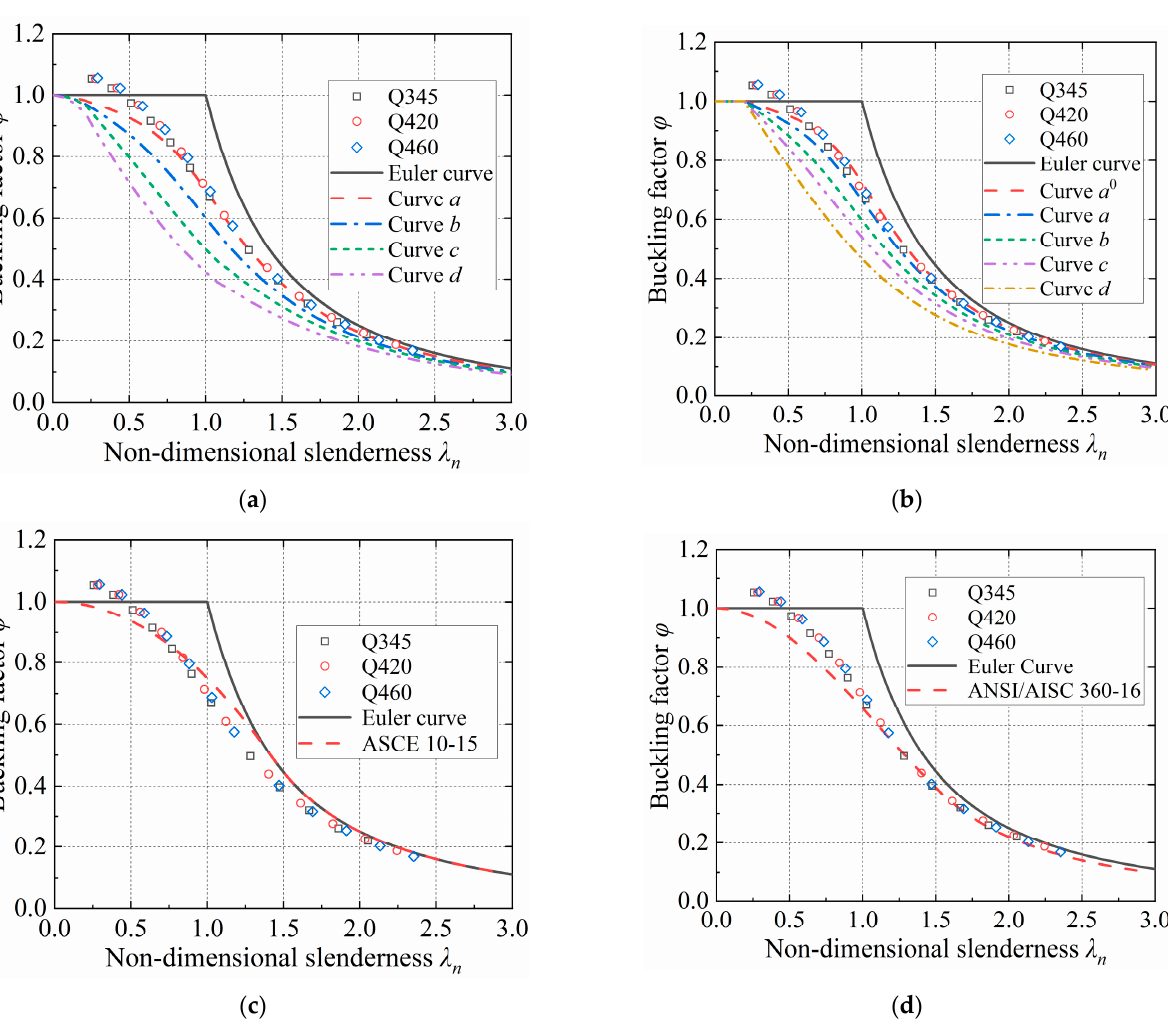
Figure 14. Comparison between FE results (different strengths) and design curves: ( a ) GB50017-2017; ( b ) Eurocode 3; ( c ) ASCE 10-15; ( d ) ANSI/AISC 360-10.